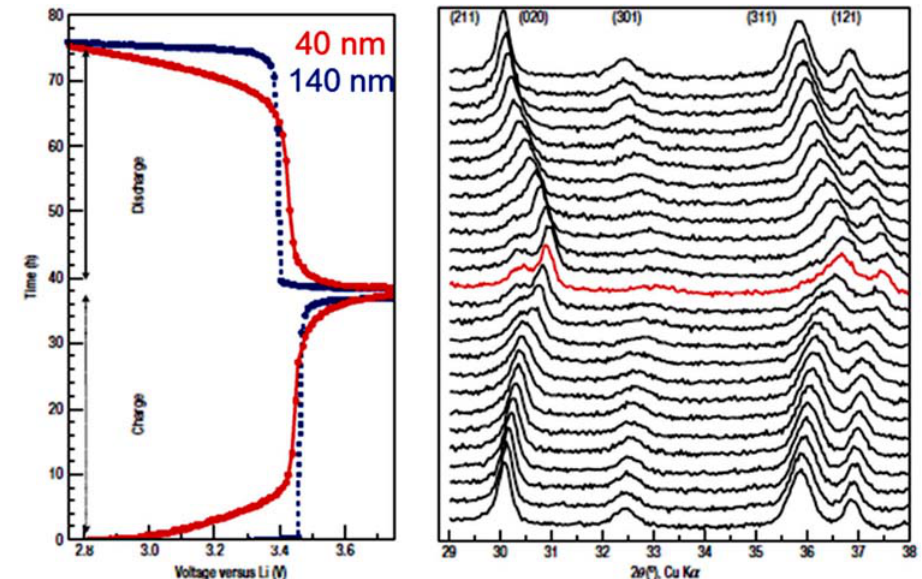
Figure 2 . Electrochemical profiles corresponding to LiFePO measurements indicate continuous shift of the diffraction peaks during the 40 nm LiFePO red pattern corresponds to the fully delithiated phase. (Reprinted from 11 with